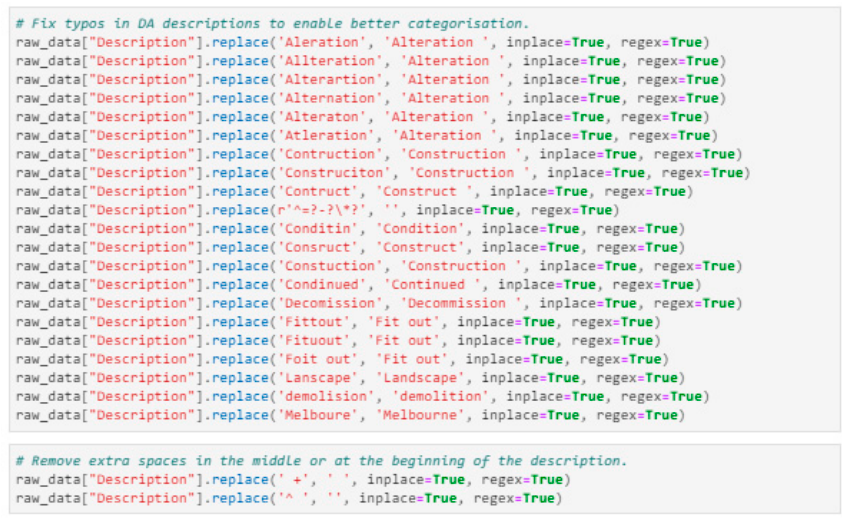
Figure 9. Sample code fixing typos and extra spaces.